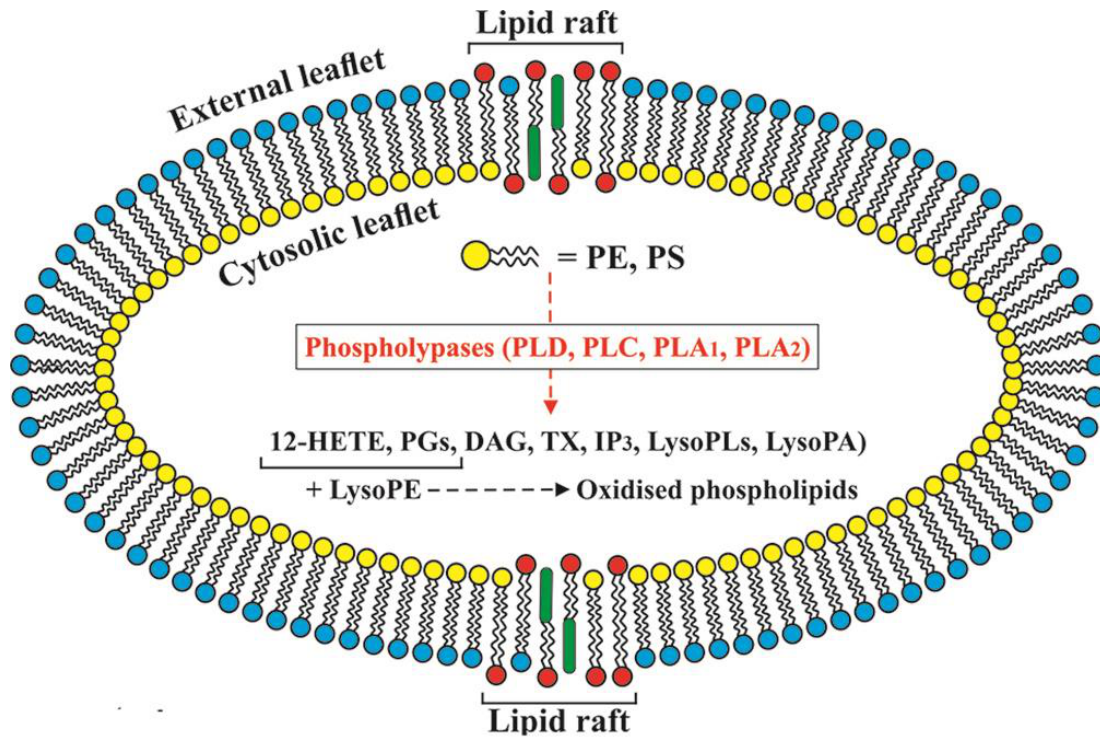
Figure 2. Enzymatic mechanisms that generate oxidized phospholipid during platelets activation: PLD—Phospholipase D; PLC—Phospholipase C; PLA 1 —Phospholipase A1; PLA 1 —Phospholipase A2; 12-HETE—12- hydroxyicosatetraenoic acid; PGs—Prostaglandins; DAG—Diacylglyceride; TX—Thromboxane; IP 3 —Inositol triphosphate; LysoPLs—Lysophospholipids; LysoPA—Lysophosphatidic acid; LysoPE—Lysophosphatidylethanolamine.